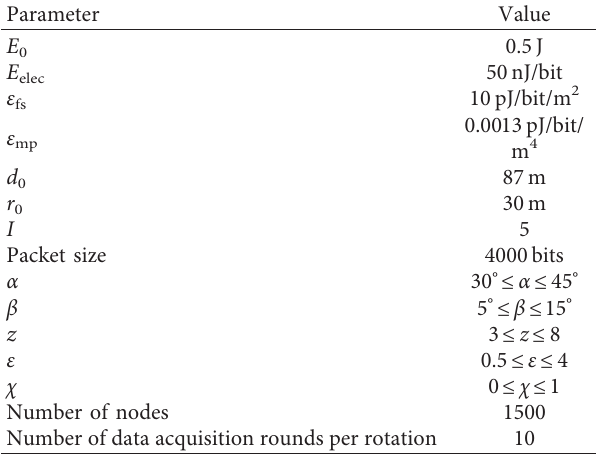
Table 1: Parameter